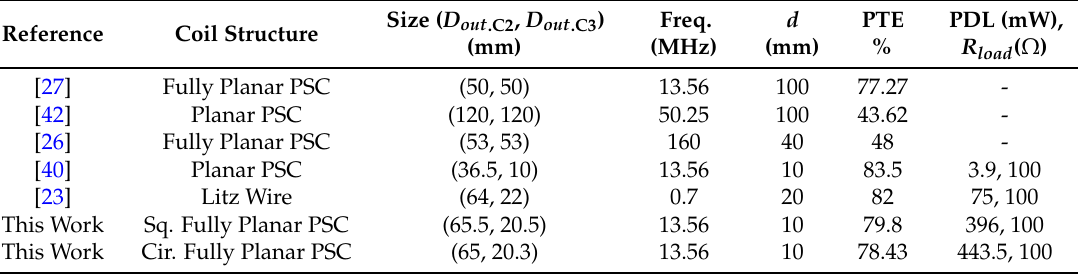
Table 5. Comparison with Previous